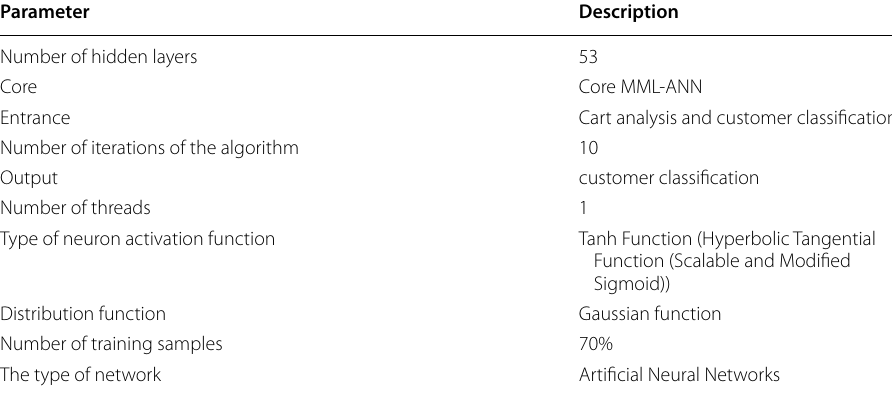
Table 7 Specifications for deep neural networks algorithm for basket analysis and customer